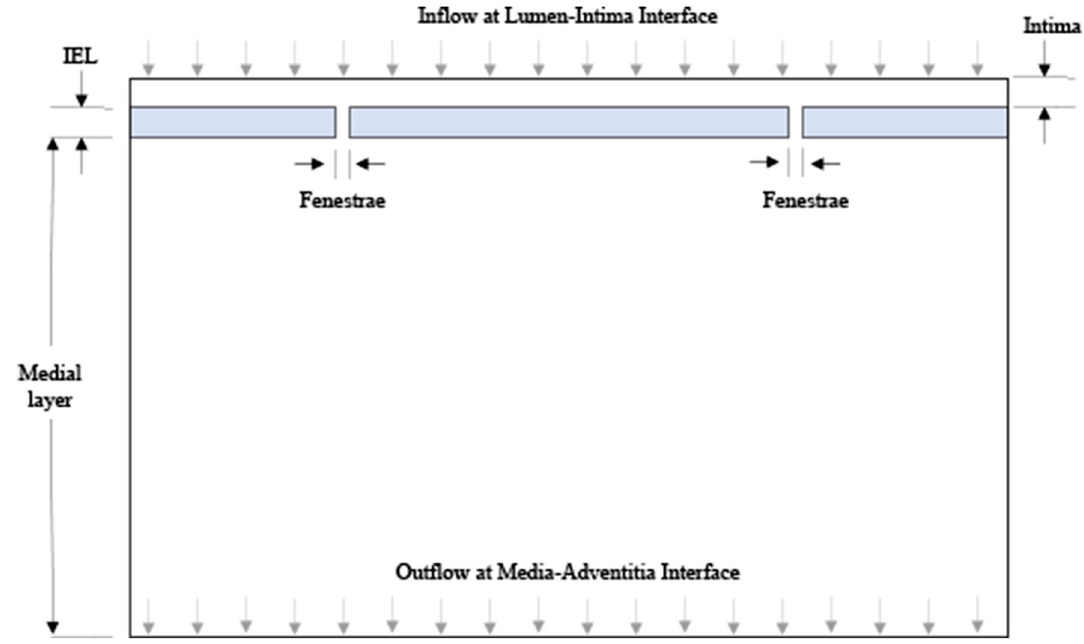
Figure 6. Schematic drawing of the two-dimensional geometric model implemented in this